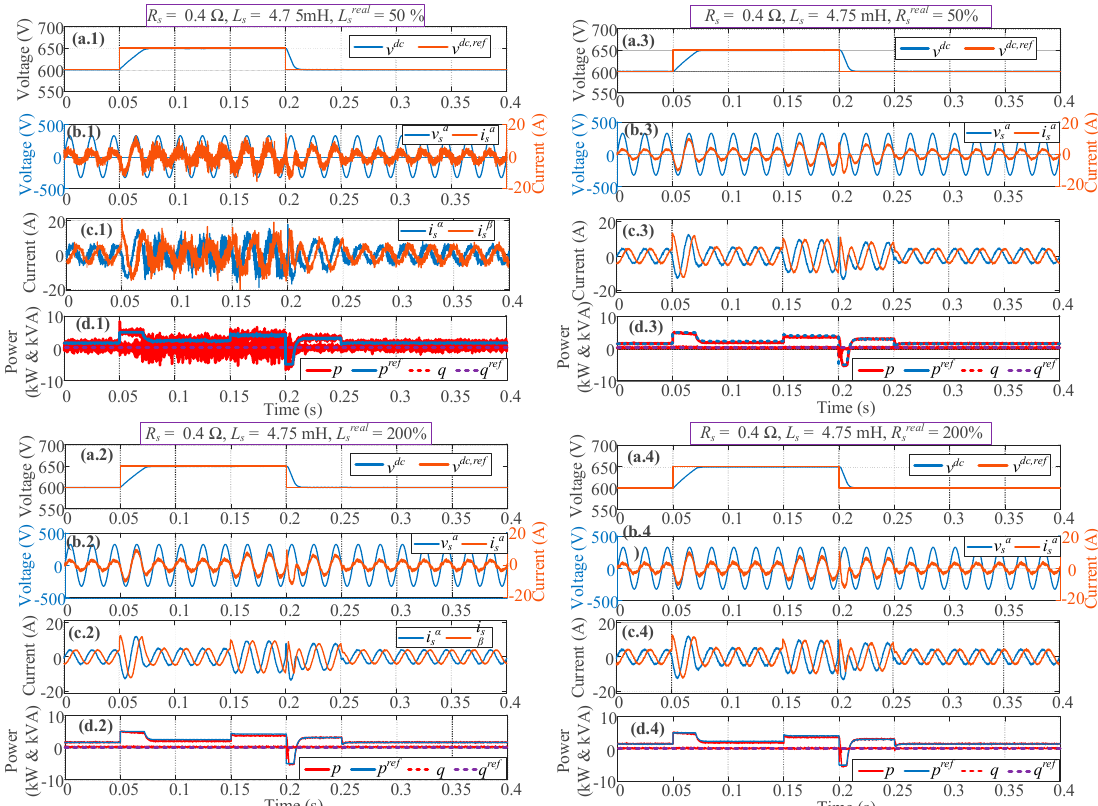
Figure 4. Model uncertainties, ( a ) dc voltage and reference, ( b ) v s α voltage and i s α current, ( c ) i s αβ currents, ( d ) active p s and reactive q s power, with ( 1 ) inductances decrease to 50%, ( 2 ) inductances increase to 200%, ( 3 ) resistances decrease to 50%, ( 4 ) resistances increase to 200%.